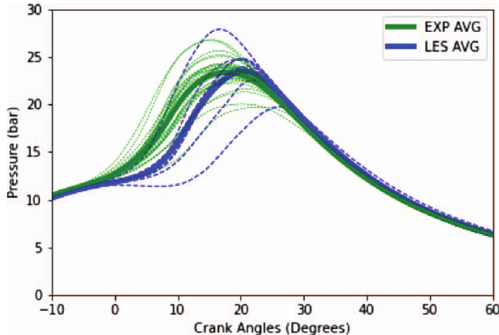
Fig. 8. WSR and LESI ignition model: peak in-cylinder pressure for LES (blue) and experiments (green). Individual cycles are denoted by the dashed lines and the ensemble average is denoted by bold lines.